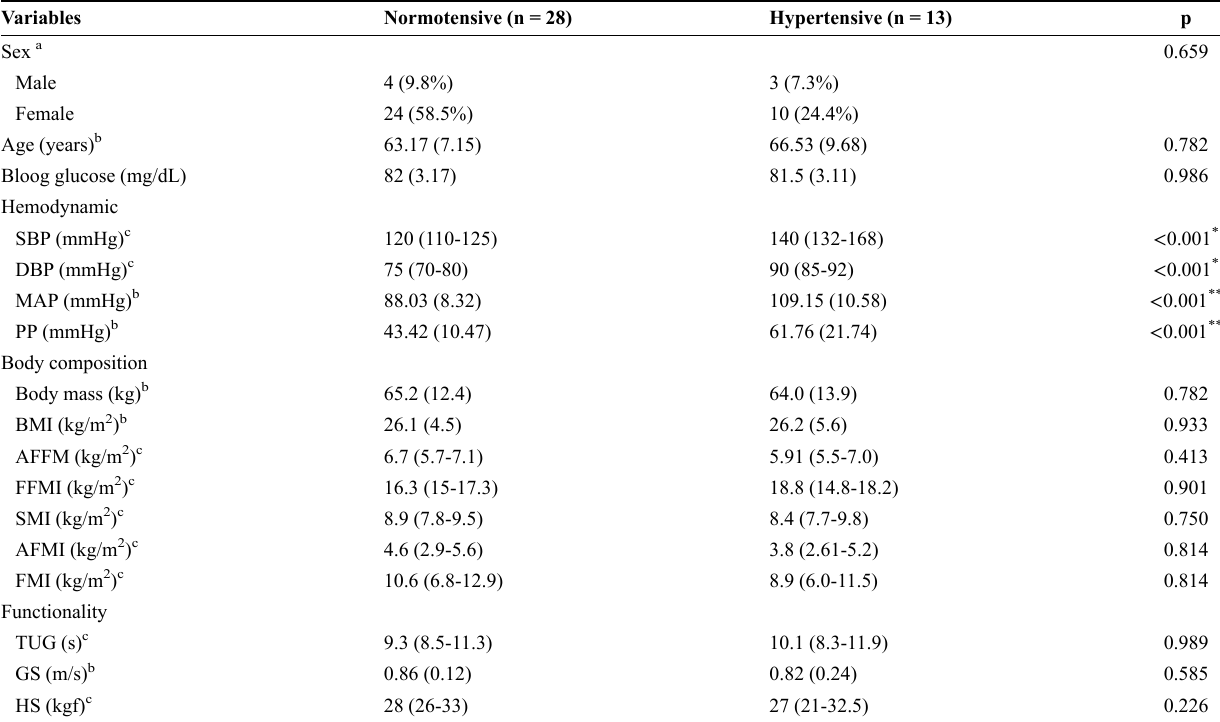
Table 1 - Clinical characteristics of study participants at baseline (n = 41).